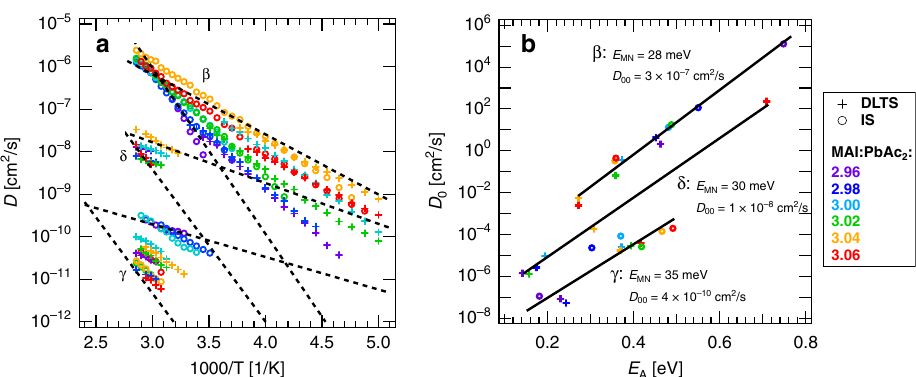
Fig. 6 Meyer – Neldel rule in two representations. a Arrhenius plot with diffusion coef fi cients over the temperature. Additional dashed lines, which correspond to the start and end points of the fi ts (solid lines) from the Meyer – Neldel plot ( b ), illustrate the range and common nature of diffusion coef fi cients for each ionic defect ( β , γ , and δ ) and for all precursor stoichiometric ratios. b Meyer – Neldel plot: diffusion coef fi cients at in fi nite temperature D 0 plotted over the corresponding activation energy E A . The characteristic energy E MN and the critical diffusion coef fi cient D 00 can be extracted from the linear fi ts (solid lines).